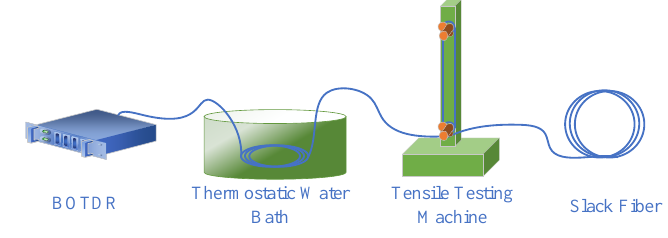
Figure 2. Fiber calibration device diagram.